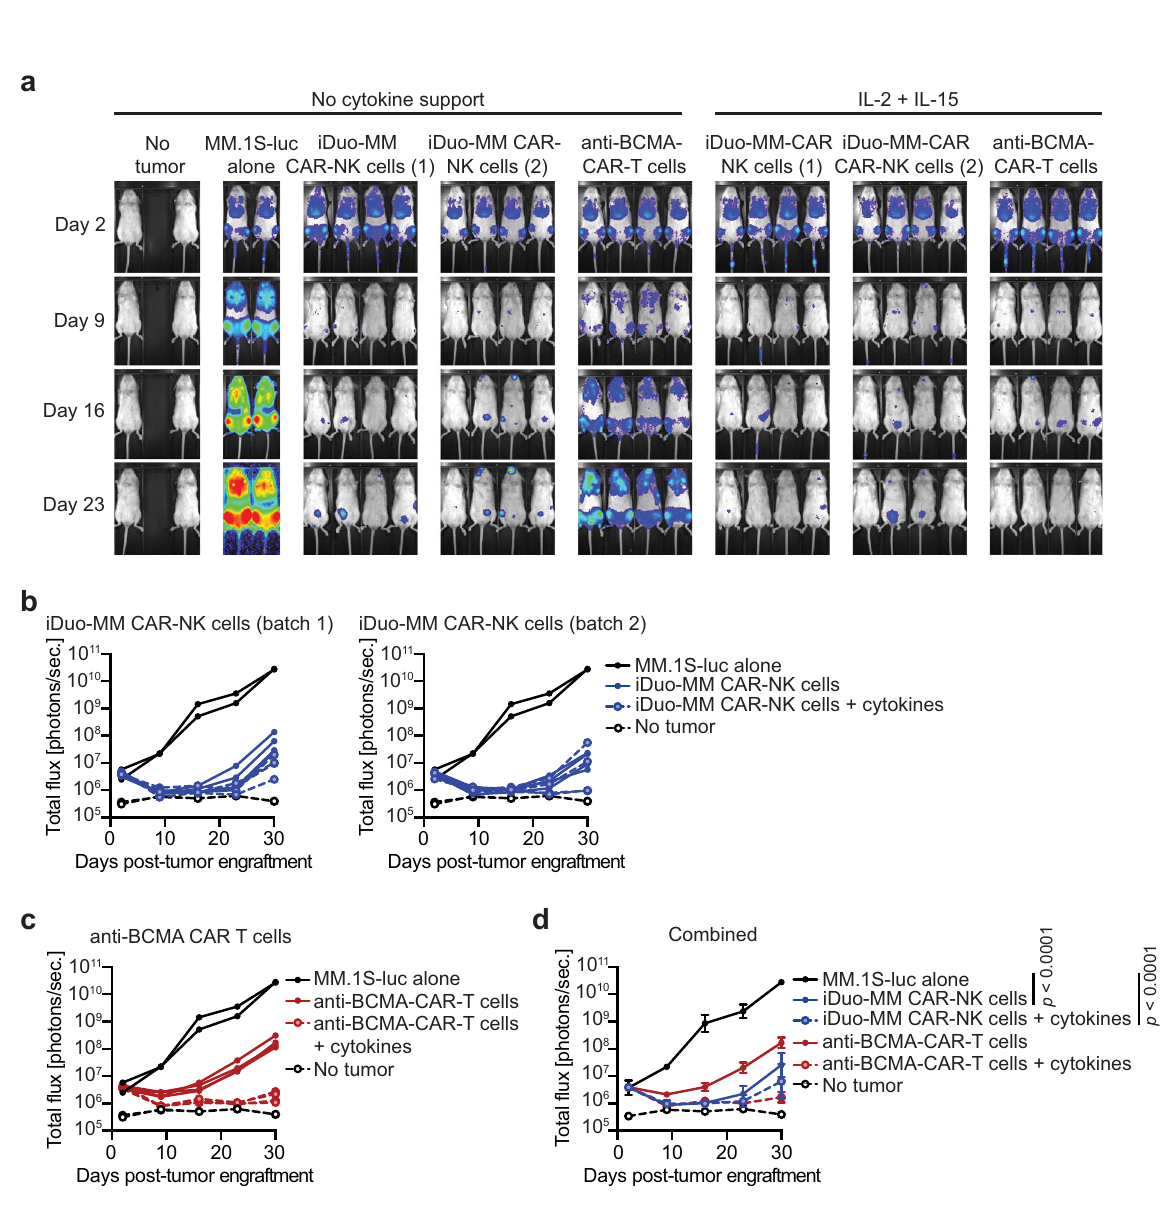
Fig. 6 | iDuo-MM CAR-NK cells maintain in vivo antitumor function in the absence of exogenous cytokine support. NSG mice ( n =26) were engrafted with 2×10 5 luciferase-transduced MM.1S cells. Groups of mice ( n =4/group) received either no treatment or i.v. injections of 1×10 7 iDuo-MM CAR-NK cellsthawed from cryopreservation on days 2, 9, and 16 post-tumor engraftment. Additional groups ofmiceweregiveni.v.injectionsof2×10 6 primaryanti-BMCA-CAR-Tcellsonday2. Two independent batches of iDuo-MM CAR-NK cells were used, and all three treated groups were split and either given no exogenous cytokine support or supplemented with twice-weekly injections of IL-2 and IL-15. a Bioluminescence